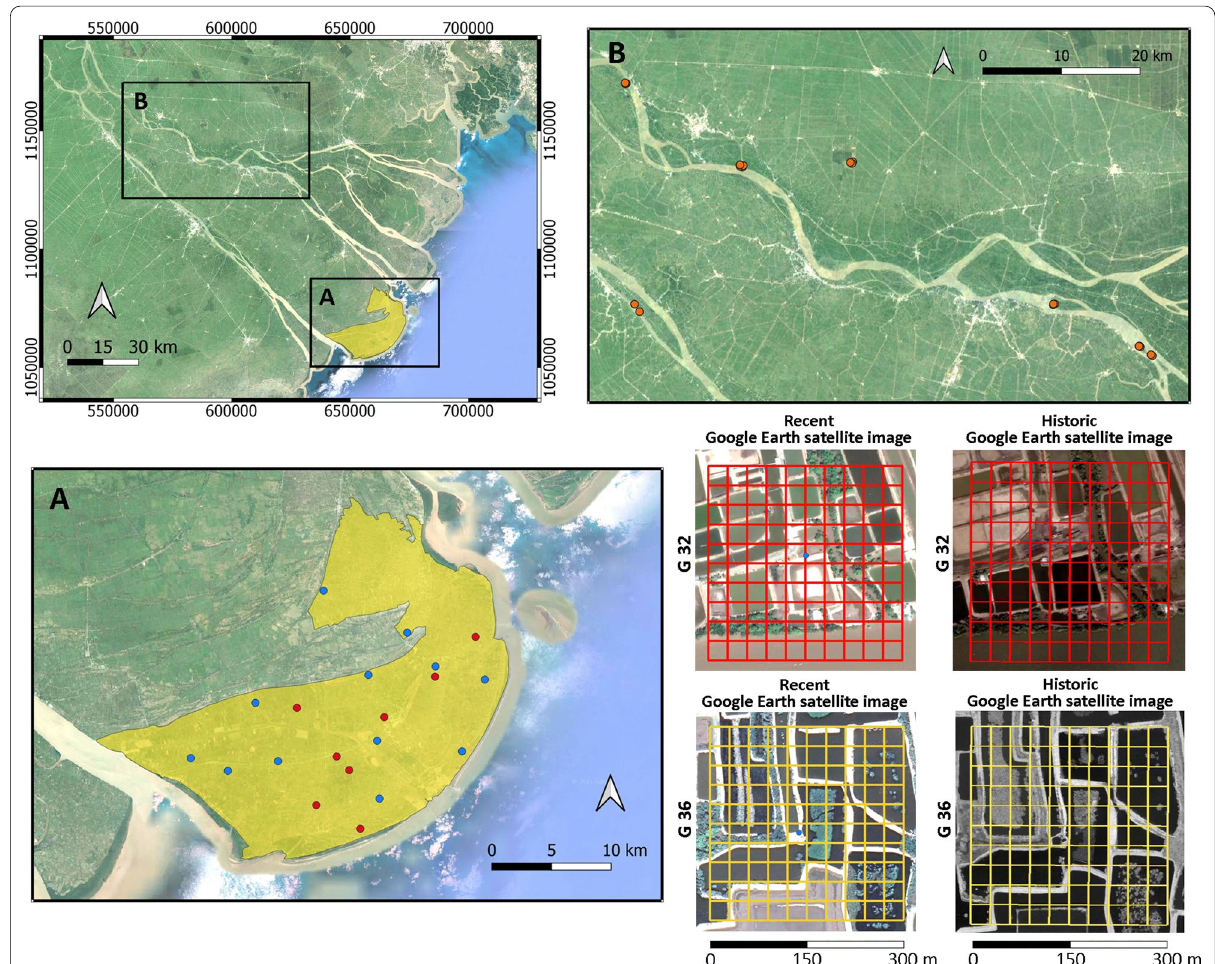
Fig. 1 The upper left panel shows the study area: the yellow polygon indicates the coastal zone with ponds used for shrimp farming, which is magnified in the A panel; the B panel shows the freshwater area. Blue points in the A panel indicate the location of the grids created around the twelve sampling points provided by Nguyen et al. (2020); red points in the A panel indicate the location of the eight additional grids randomly generated; orange points in the B panel indicate the location of the grids created on freshwater ponds. The images of the grids of 10 30 m 30 m each) in the bottom right of the figure correspond to the grids created around point with ID 32 and around point with ID 36 overlaid × on the most recent and on the historic Google Earth satellite images (see Table 1 for the exact dates of the images). Coordinate reference system: WGS84 UTM Zone 48. Maps were produced in QGIS and Google Earth Pro using Google Earth satellite